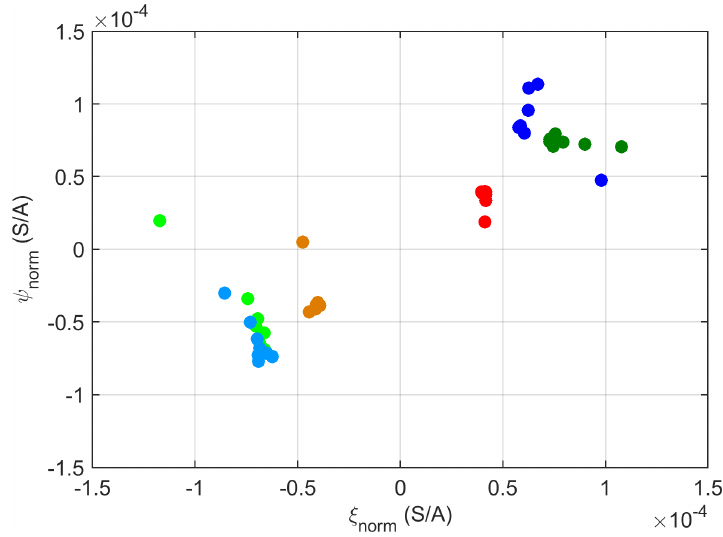
Figure 8. Scatter plot of the normalized ξ and ψ . The traction conditions on the right-hand side are indicated by dark green, blue, and red for CH, D, and F, respectively; similarly, braking conditions on the left-hand side have corresponding lighter